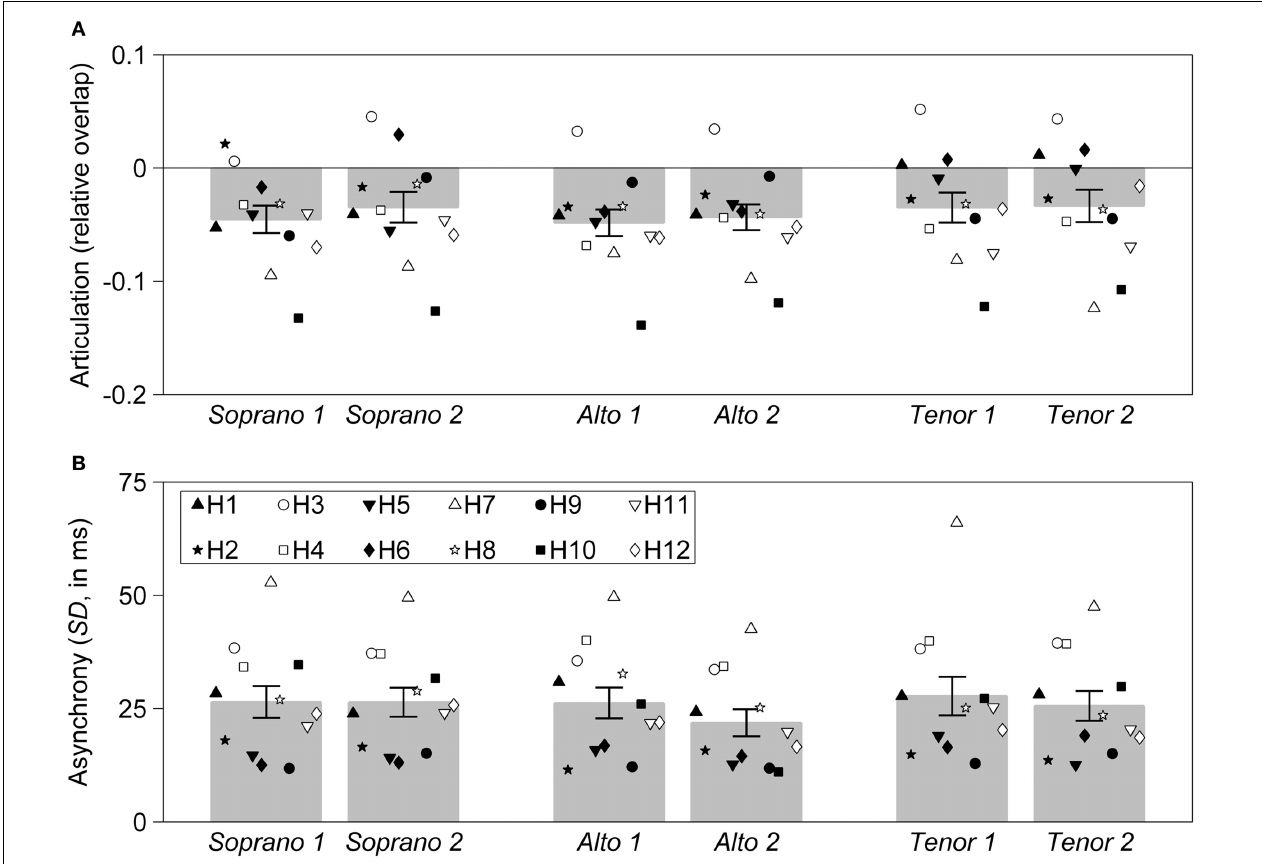
FIGURE 2 | Mean values for articulation and asynchrony, for all three interpretations of the Partita . Each individual harpsichordist (identified as H1, H2, ..., H12) is represented by a unique symbol. Each symbol represents a single recording. Three interpretations, each emphasizing a different melodic line (corresponding to the soprano, alto, or tenor part) were recorded. Each interpretation was recorded twice, with successive